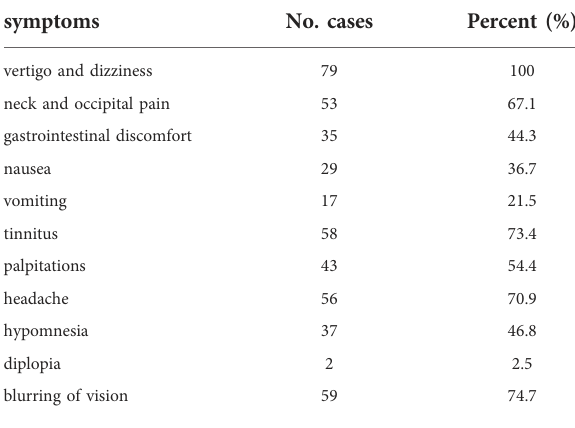
TABLE 7 Number and incidence of other symptoms accompanied with vertigo.